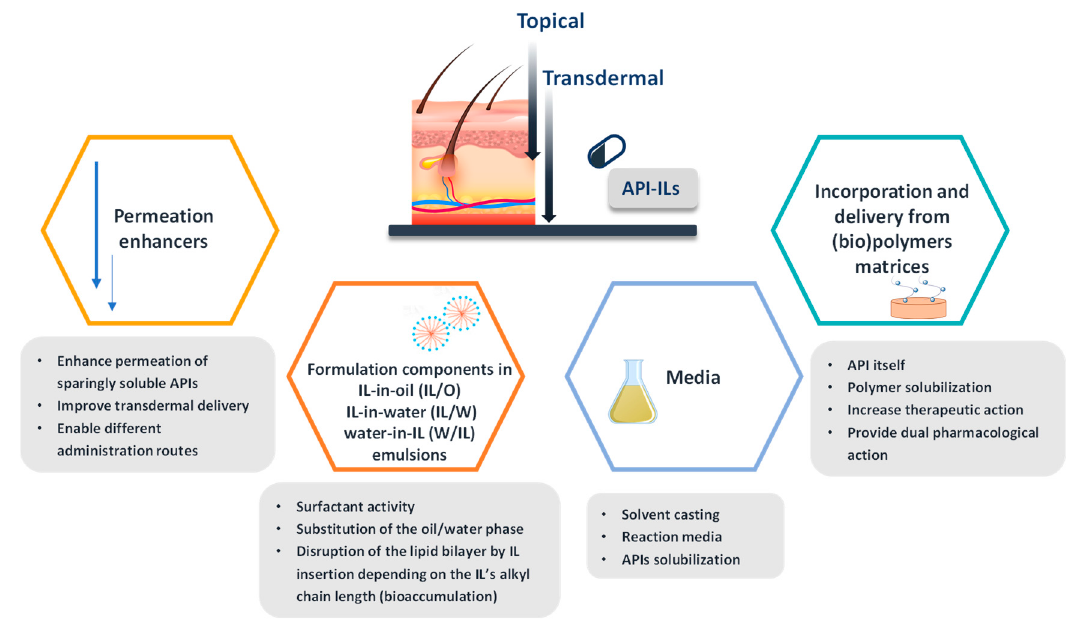
Figure 18. IL applications in the development of drug delivery systems for topical and transdermal administration (adequate references are given along the current section).